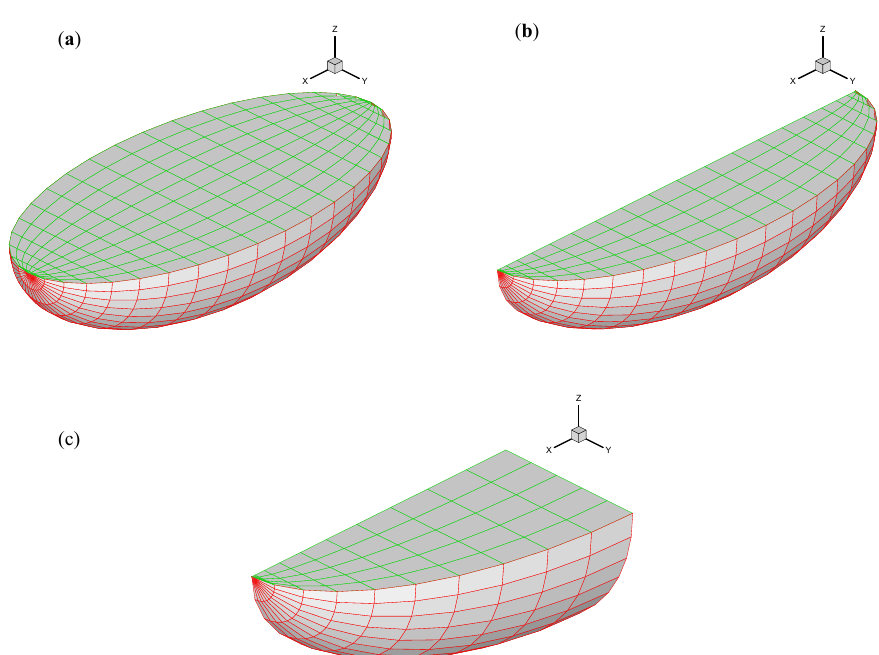
Figure 6. Mesh of the floating ellipsoid ( a ) without symmetry in 600 panels; ( b ) with one symmetry in 300 panels; and ( c ) with two symmetries in 150 panels.